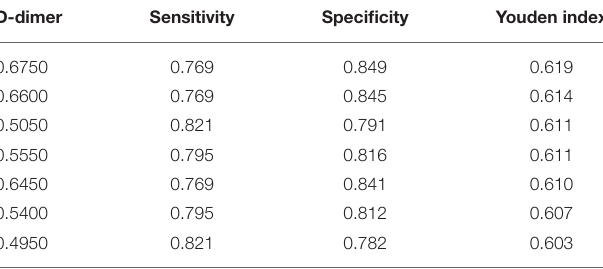
TABLE 6 | Diagnostic efficacy of D-dimer for AAA determined by Youden